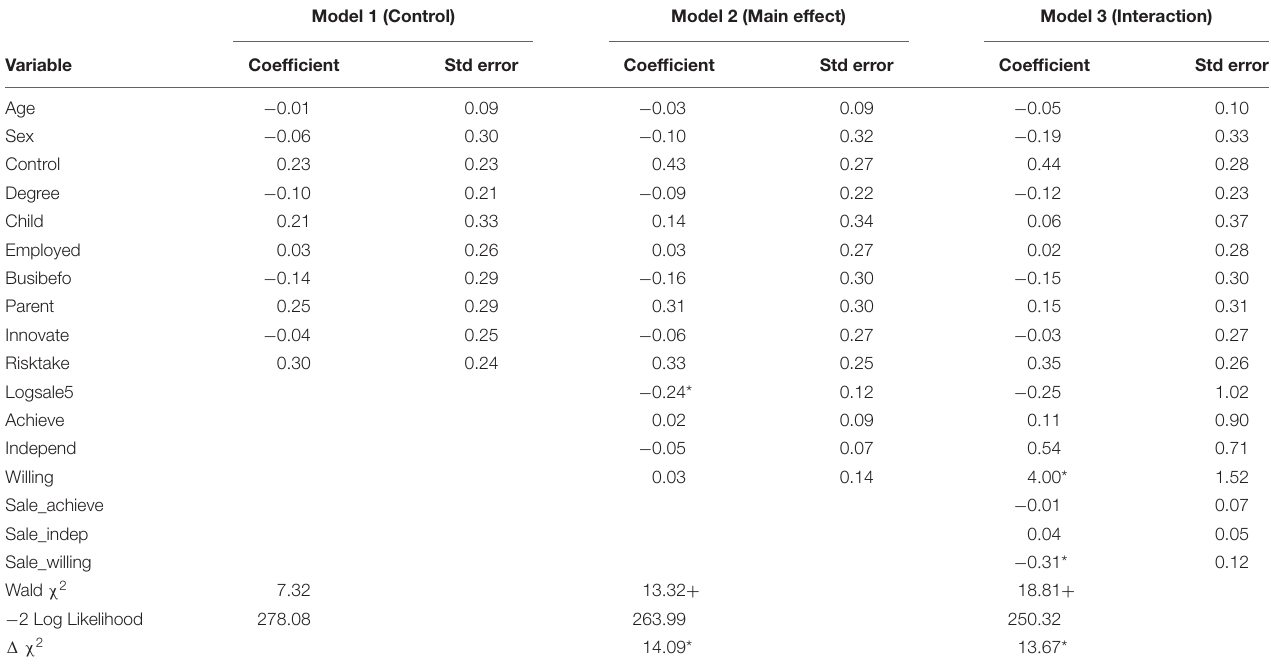
TABLE 2 | Logistic regression results of motivations and wealth aspiration on satisficing search.